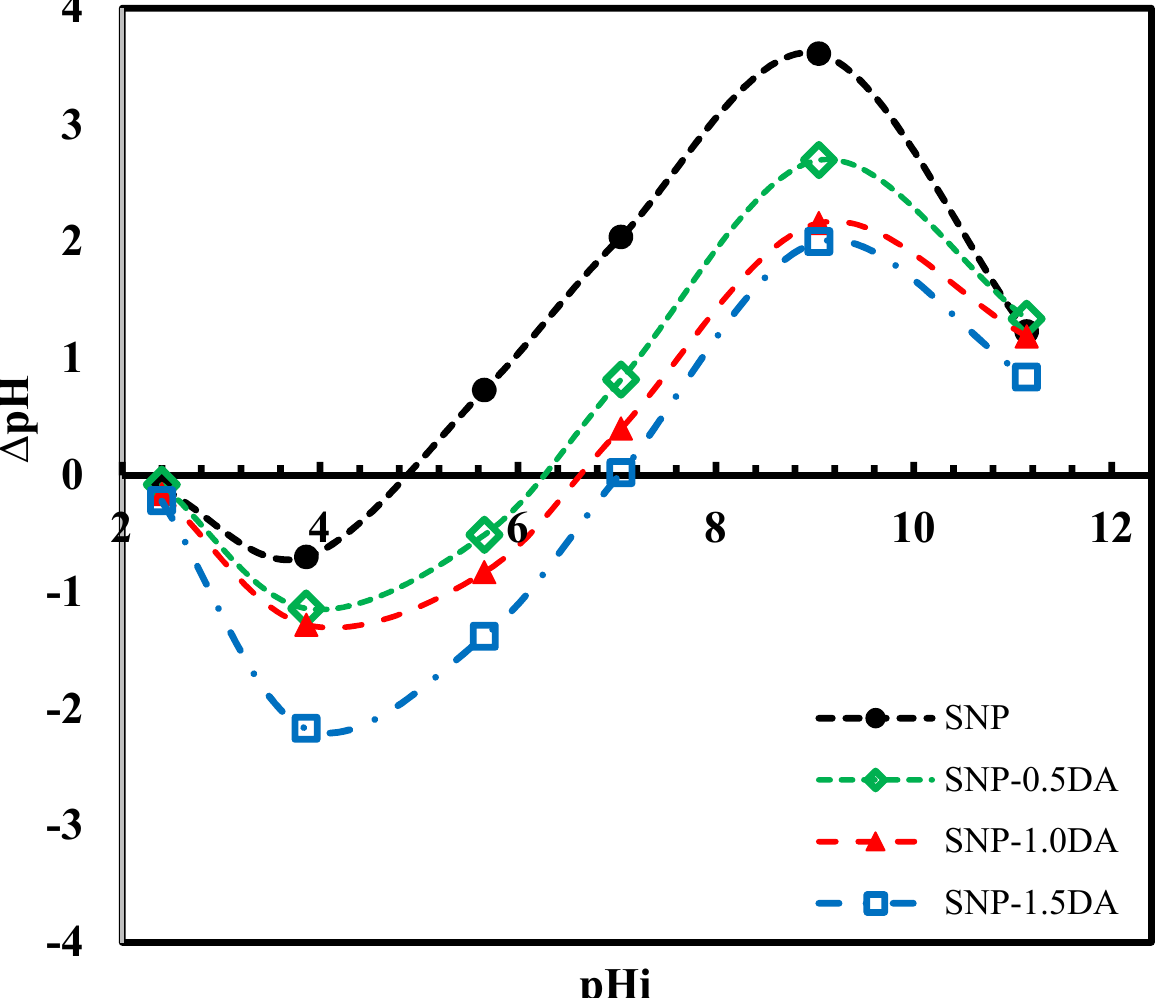
Figure 6. The pH of zero-point charge equilibrium curve for the nanocomposites prepared with different amounts of DA.